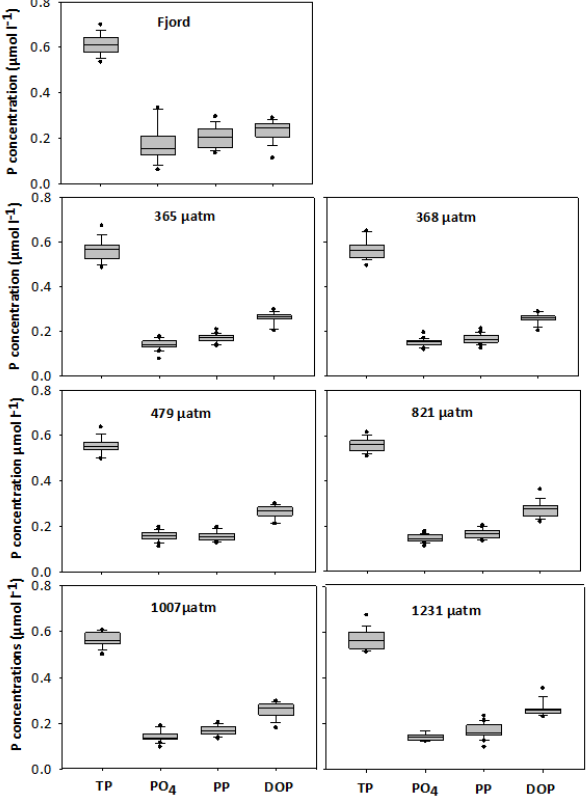
Figure 6. Contribution of the individual P-fractions to TP in fjord water and in the respective mesocosms. The data are averaged for the period when TP measurements were done (day − 3 to day